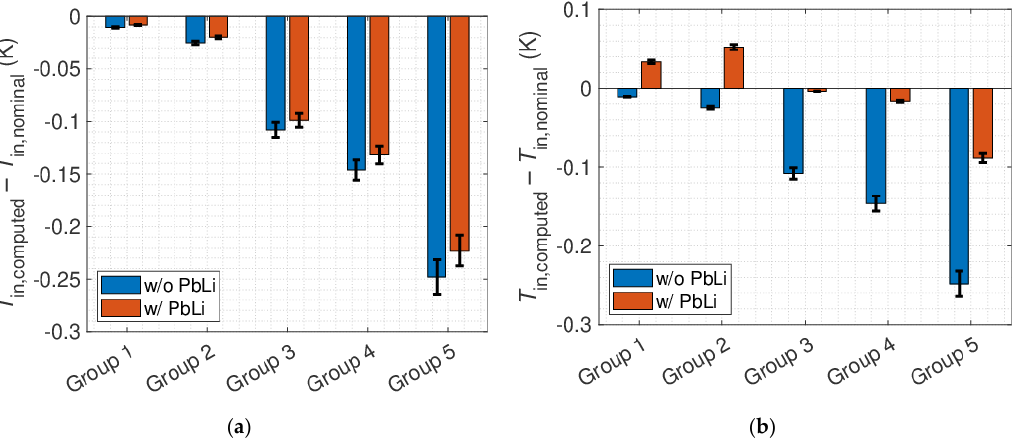
Figure 17. Distribution of the difference between the computed channel inlet temperature and its design value (295 °C), for the case without and with heat transfer with the PbLi manifolds, for the BZ circuit: ( a ) HTC from correlation; ( b ) infinite HTC. Negative numbers mean that the computed inlet temperature is smaller than its nominal value. (Refer to Figure 6 for the channel group nomenclature.).